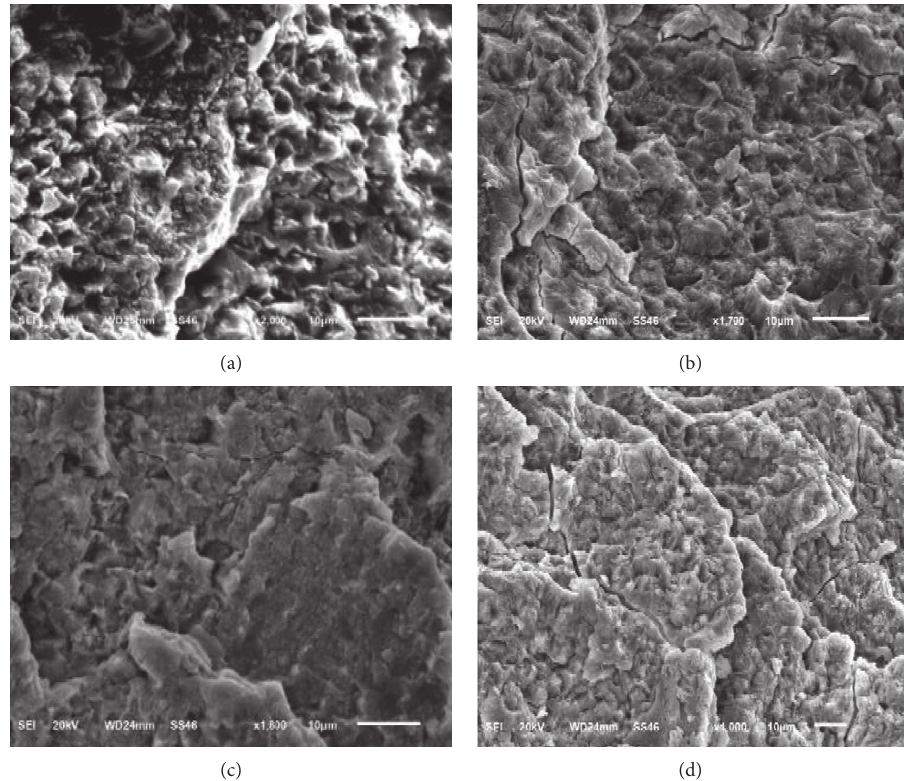
Figure 5: SEM images of laser-etched samples irradiated for 5 s at 1W power (a), 1.5 W power (b), 2W power (c), and 2.5W power